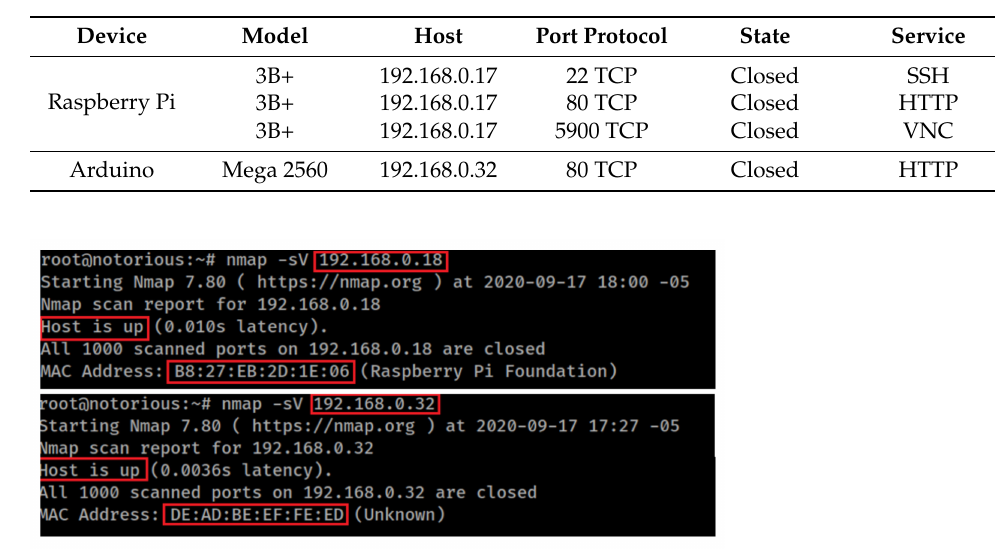
Figure 13. Ports scan Raspberry